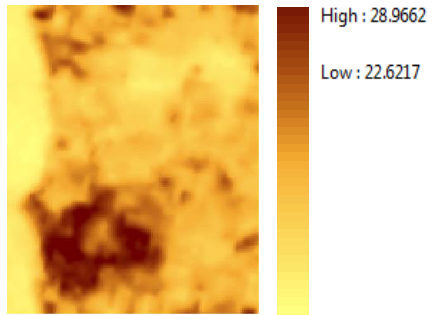
Figure 2. 2014 Land Surface Temperature